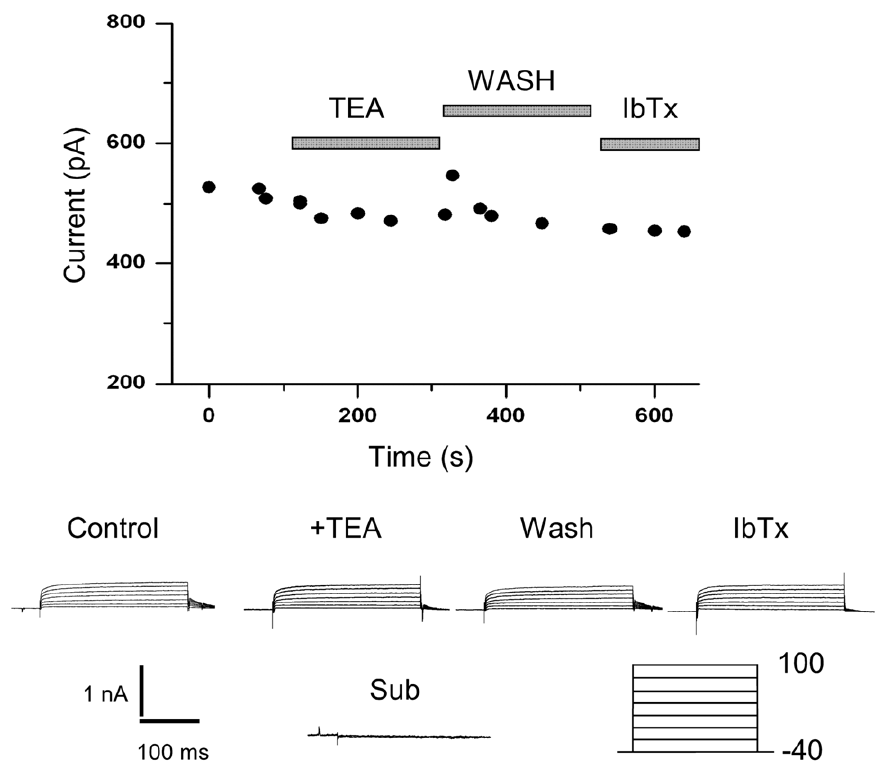
Figure 5. P0 outward currents are insensitive to TEA. Perforated whole-cell current of a SN DA neuron at P0. The whole cell patch was obtained and the current was recorded for five minutes to assay for decay. After 5 min, 20 mM TEA was applied in a fast perfusion system. No appreciable diminution of the current was observed. The slice was then washed. After the wash, 1 m M IbTx was applied. No effect was observed on the outward current. The voltage protocol is indicated below the